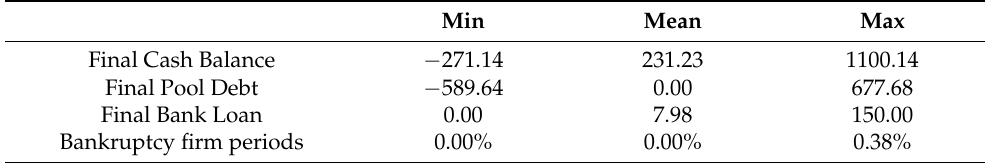
Table 18. Results for diverse operational risk, loan limits, and interest rates with